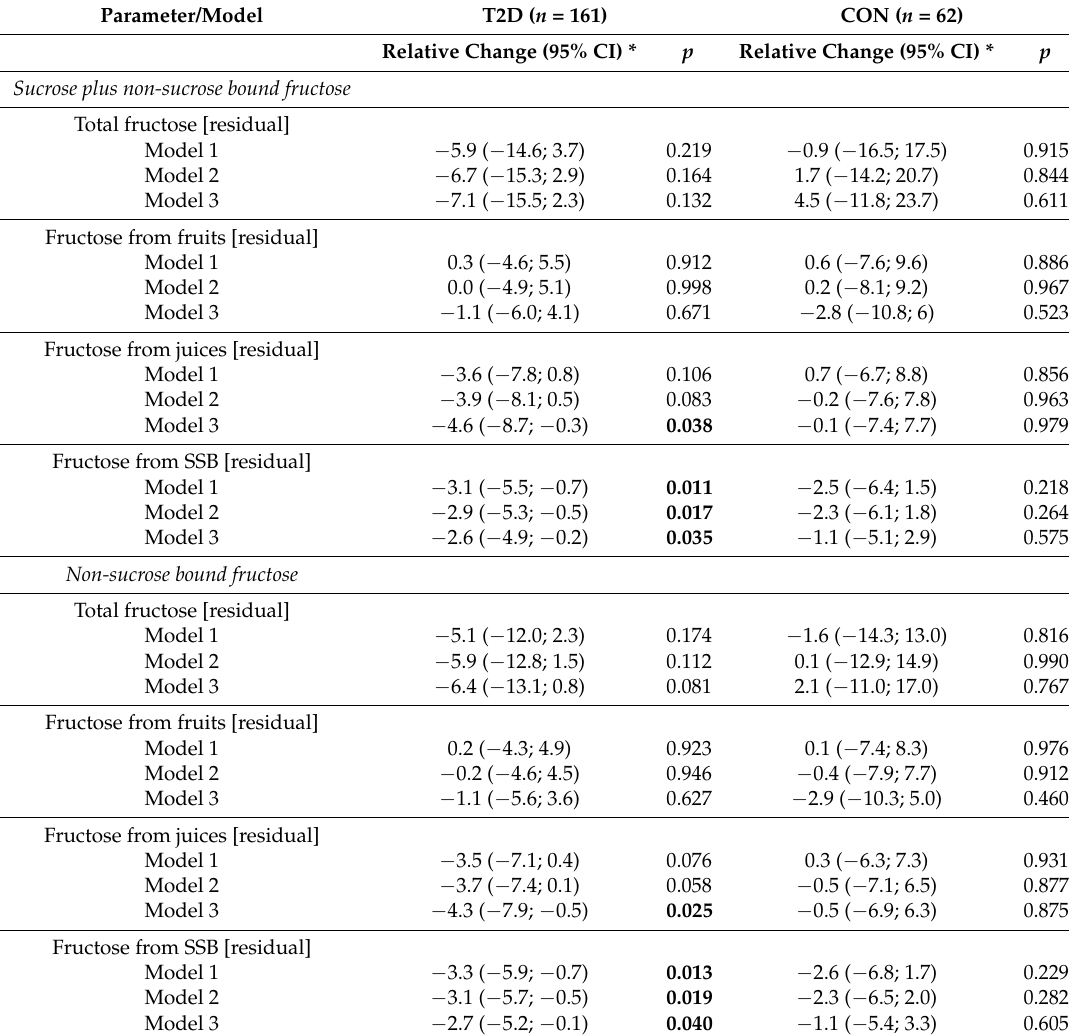
Table 3. Association of fructose intake with peripheral insulin sensitivity (M-value) in patients with type 2 diabetes and individuals without